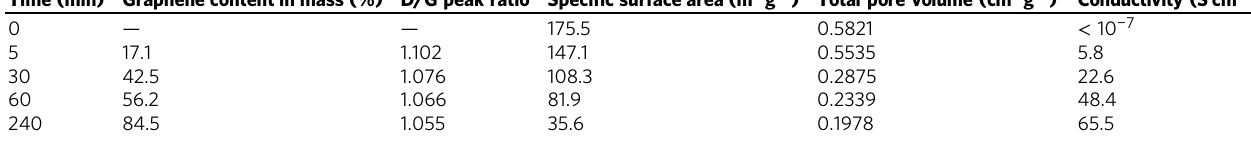
Table 1 Various properties of graphene ball at different CVD reaction